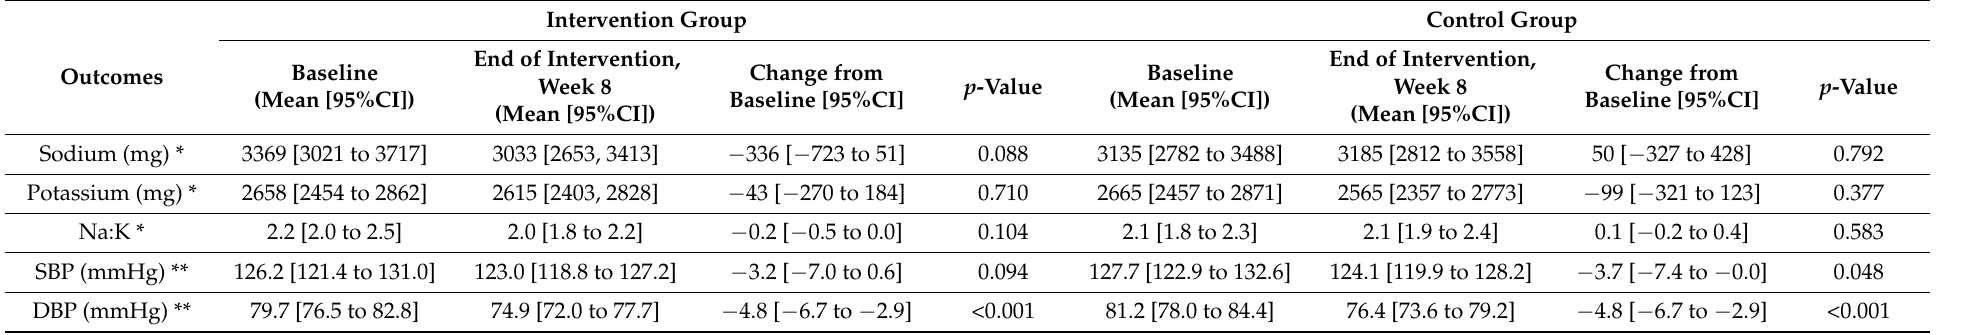
Table 2. Adjusted mean difference in urinary excretion of sodium and potassium, Na:K ratio, blood pressure based on intention-to-treat analysis in an intervention to reduce salt